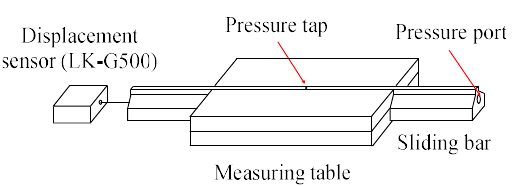
Figure 3. Schematic of the apparatus for pressure distribution measurement.